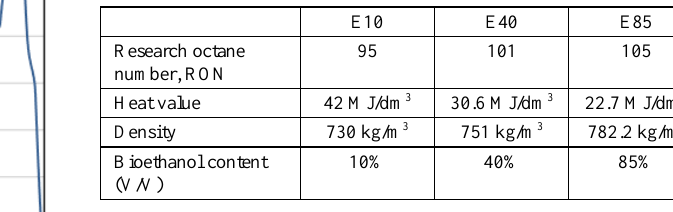
Fig. 3. The benchmark tests Table 3. Basic parameters of E10, E40 and E85 fuels